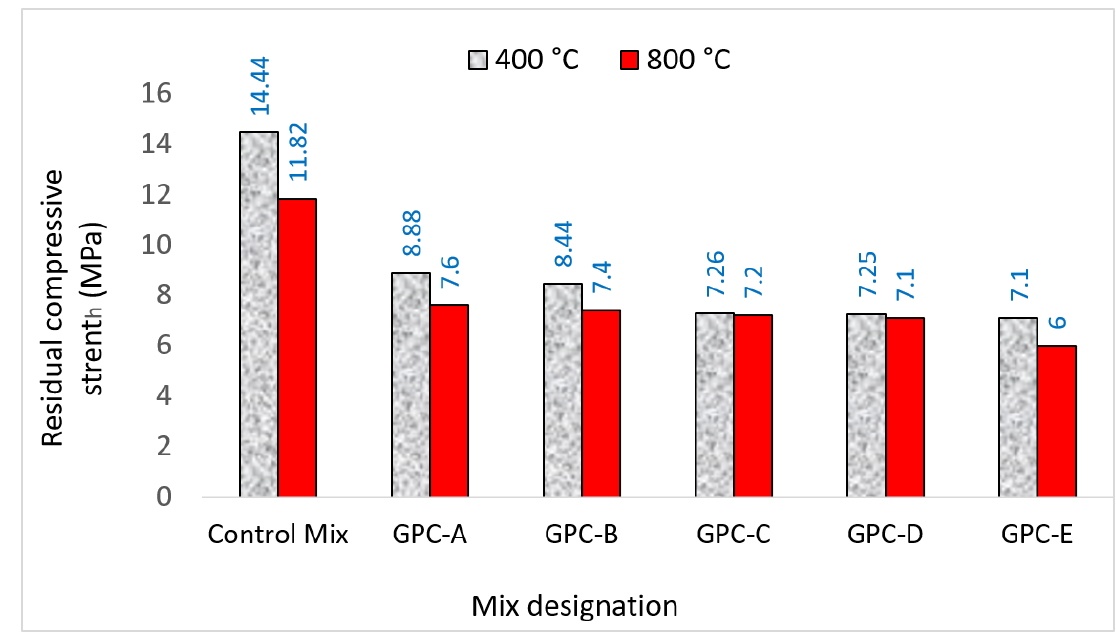
Appl. Sci. 2021 , 11 , x FOR PEER REVIEW